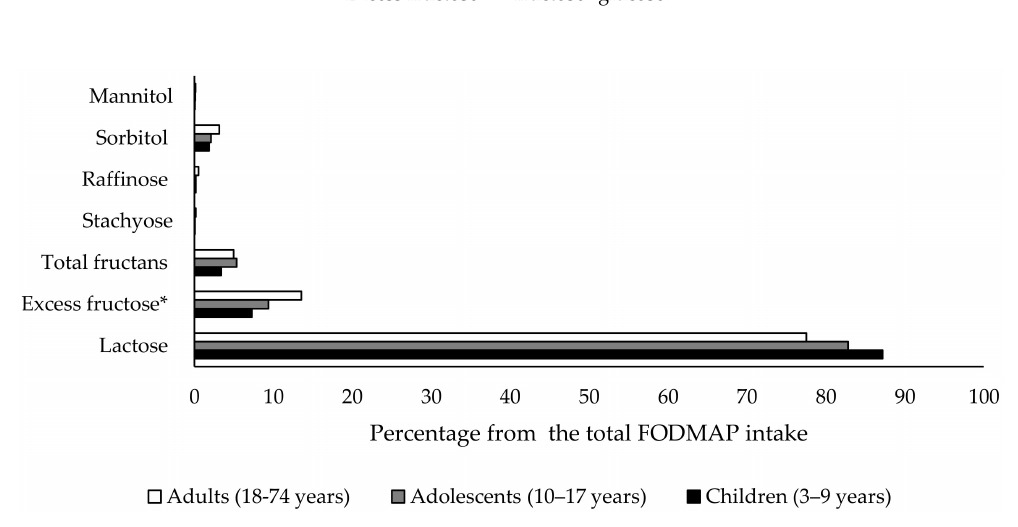
Figure 1. Influence of lactose, excess fructose, total fructan, stachyose, ra ffi nose, sorbitol and mannitol to the total FODMAP intake of Spanish population in di ff erent